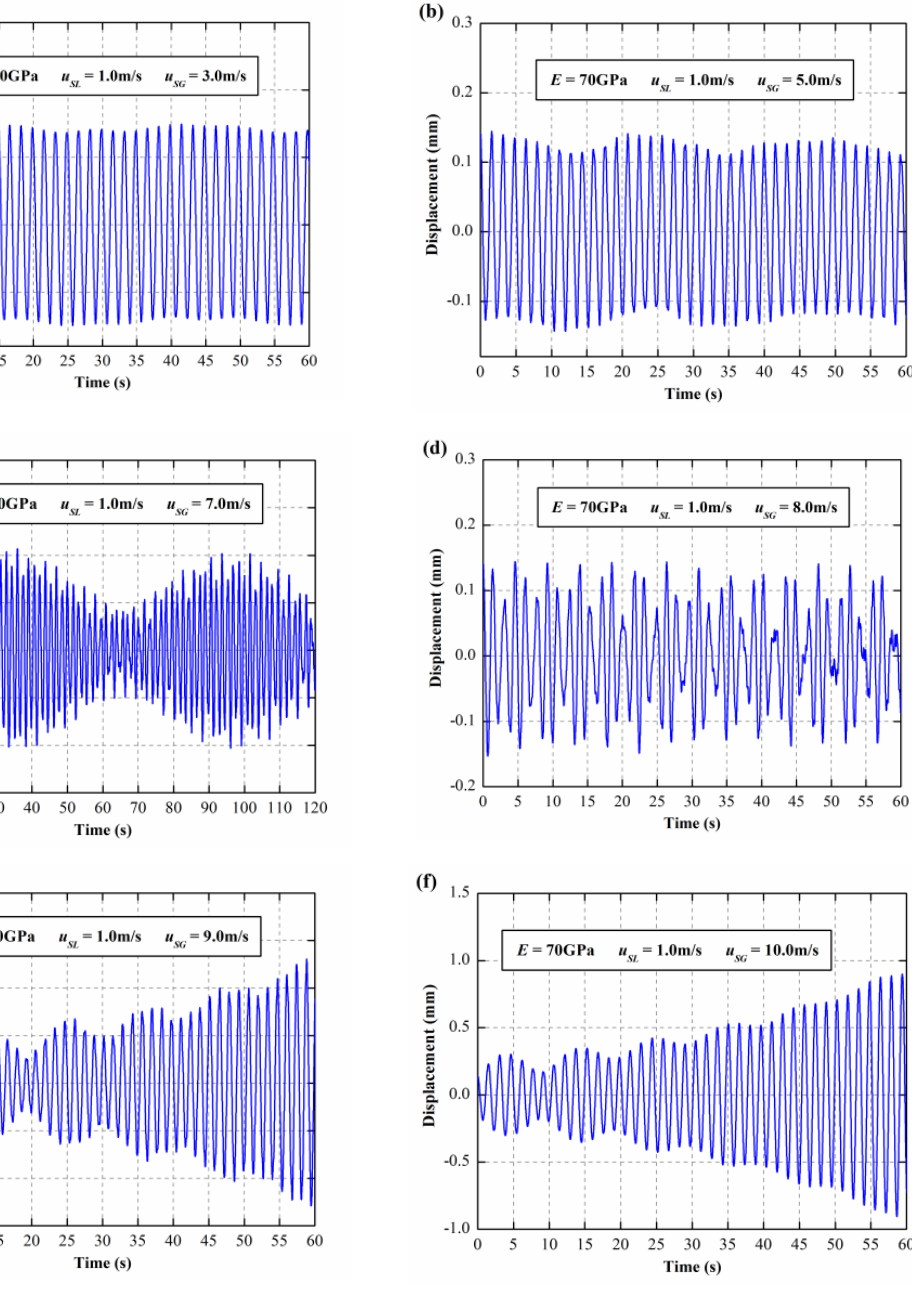
Figure 6. Midpoint displacement of the piping system for E = 70 GPa and u SL = 1.0 m/s (( a ): u SG = 3.0 m/s; ( b ): u SG = 5.0 m/s; ( c ): u SG = 7.0 m/s; ( d ): u SG = 8.0 m/s; ( e ): u SG = 9.0 m/s; ( f ): u SG = 10.0 m/s).